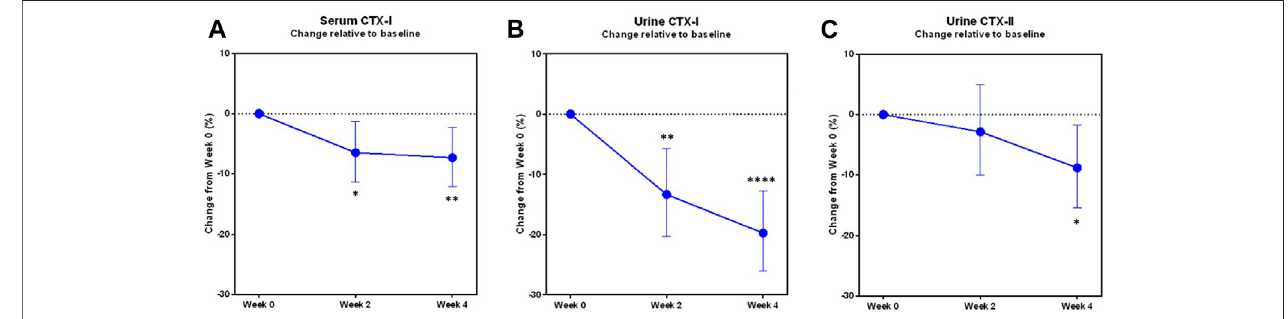
FIGURE 2 | Changes in biomarkers of bone and cartilage turnover during the trial in pooled study groups. The least-square mean proportional changes from baseline in the biomarkers of bone resorption (A) sCTX-I, (B) uCTX-I, and of cartilage degradation (C) uCTX-II, in the modi fi ed Intention-to-treat population with pooled